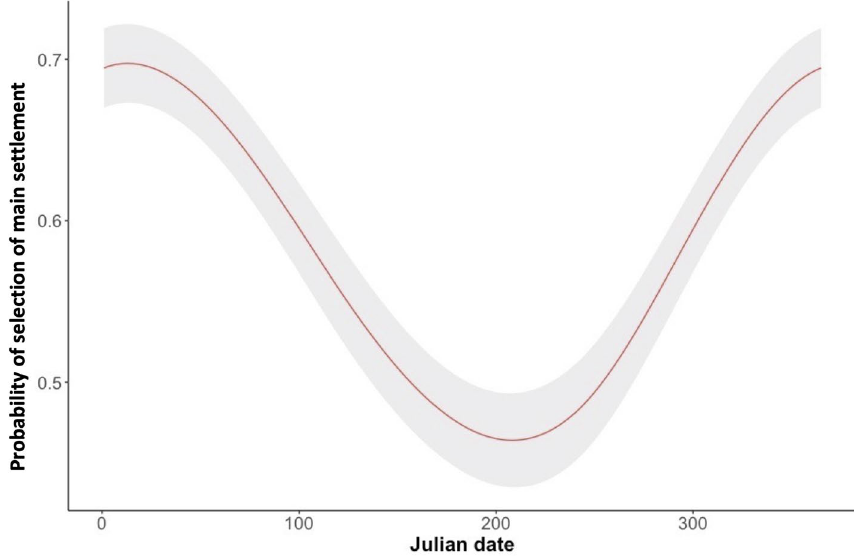
Figure 2. Probability of selection of the settlements (main vs secondary) by crested porcupine in Central Italy as predicted by the Generalised Additive Model (with a binomial error distribution) including reproductive status, cohabitation, Julian day, and family ID as predictive variables, sample size = 2221. The figure shows the effects exerted by Julian date. The predictions are given setting reproductive status = 1, cohabitation = 0, and family ID = 1. In the graph the colour-shaded areas are the estimated standard errors.